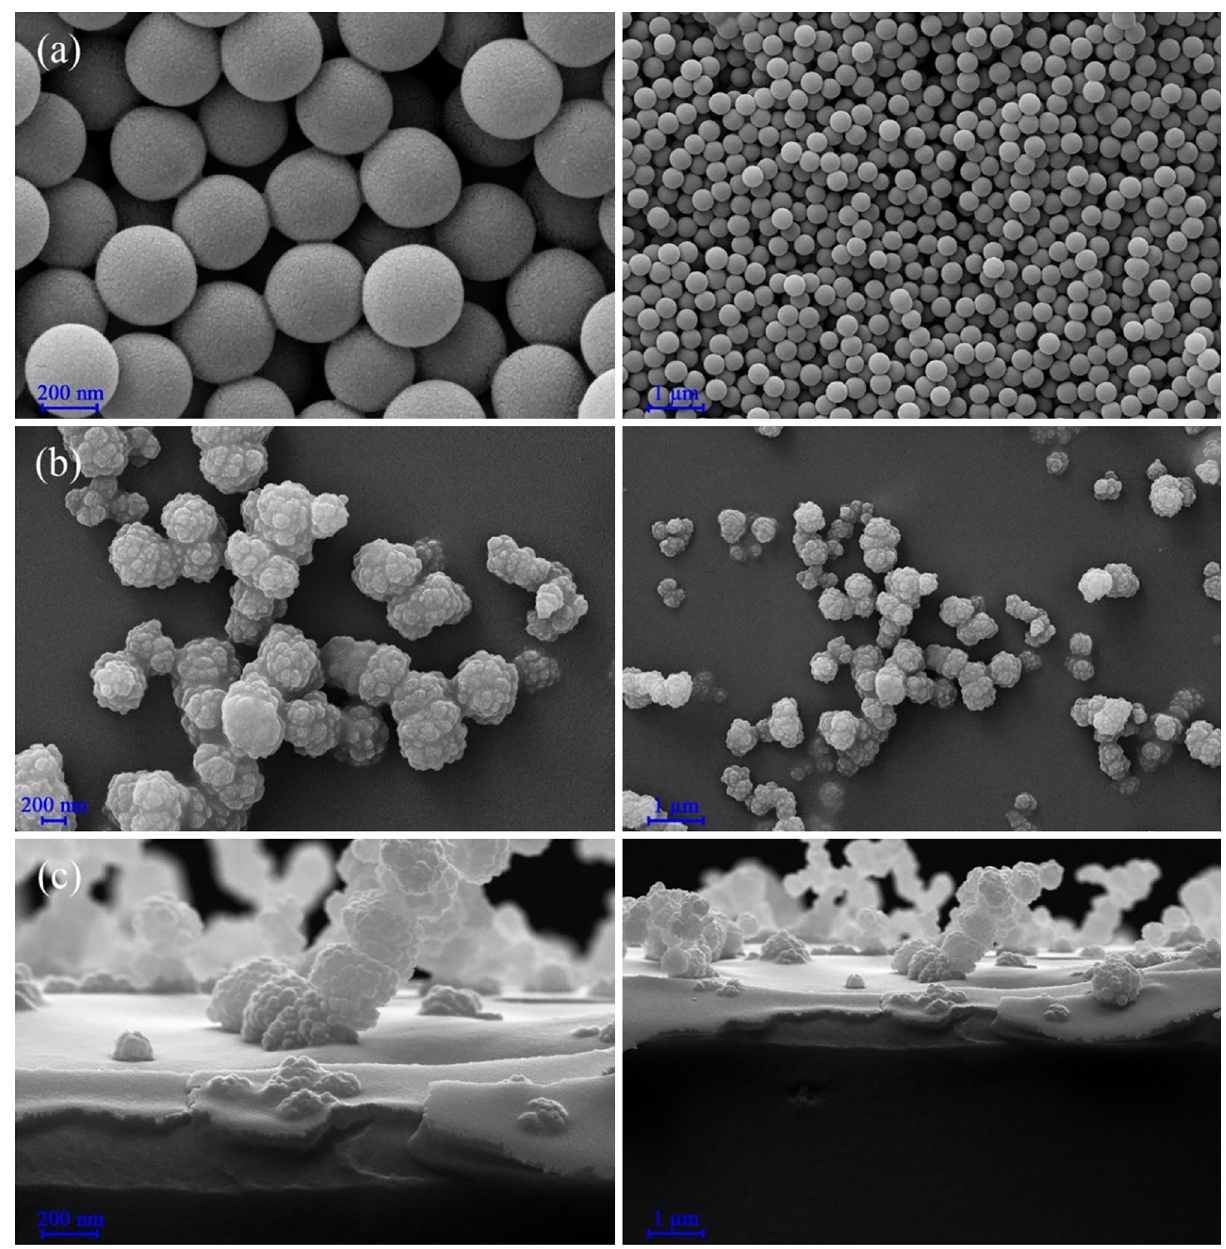
Figure 9. ( a ) SEM images of the optimized sample, ( b ) SEM images of the glass surface, and ( c ) cross-sectional SEM images of silica-coated